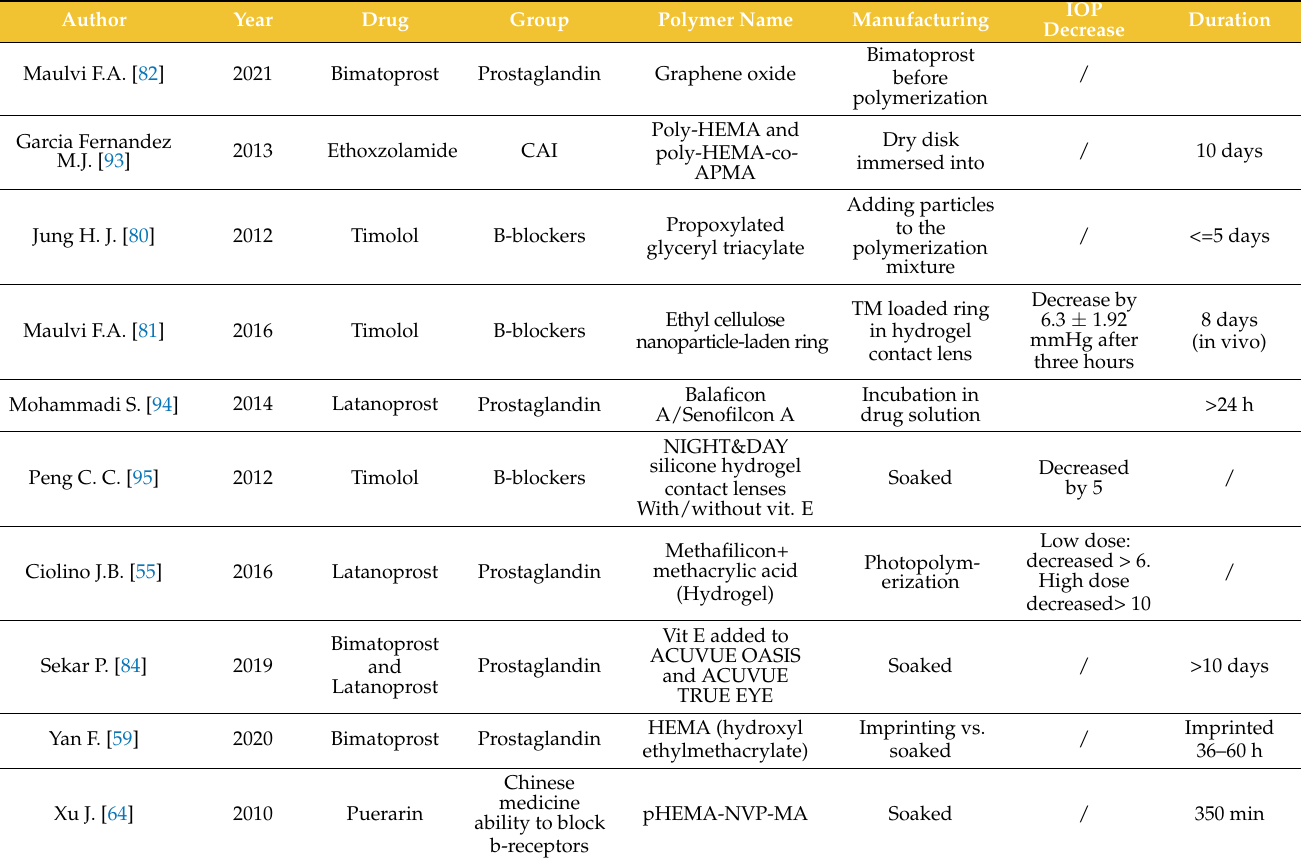
Table 1. Studies on contact lens